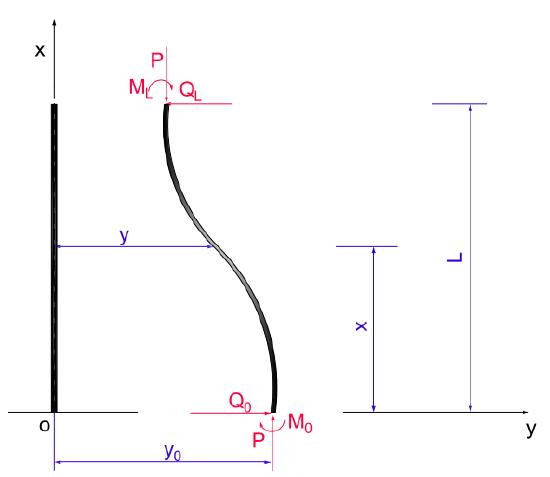
Figure 2. Compression rod under the axial force, shear force, and bending moment.